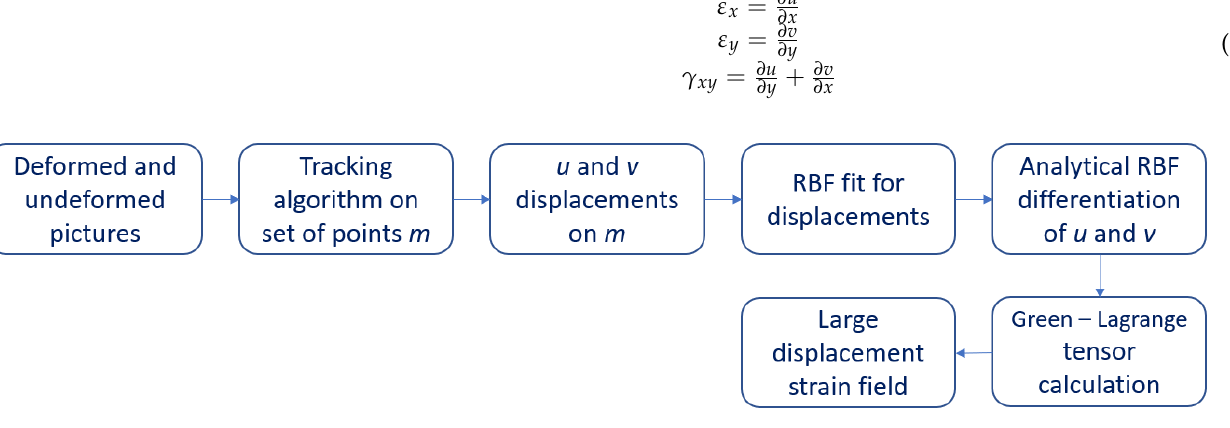
Figure 1. Flow chart of the proposed method .